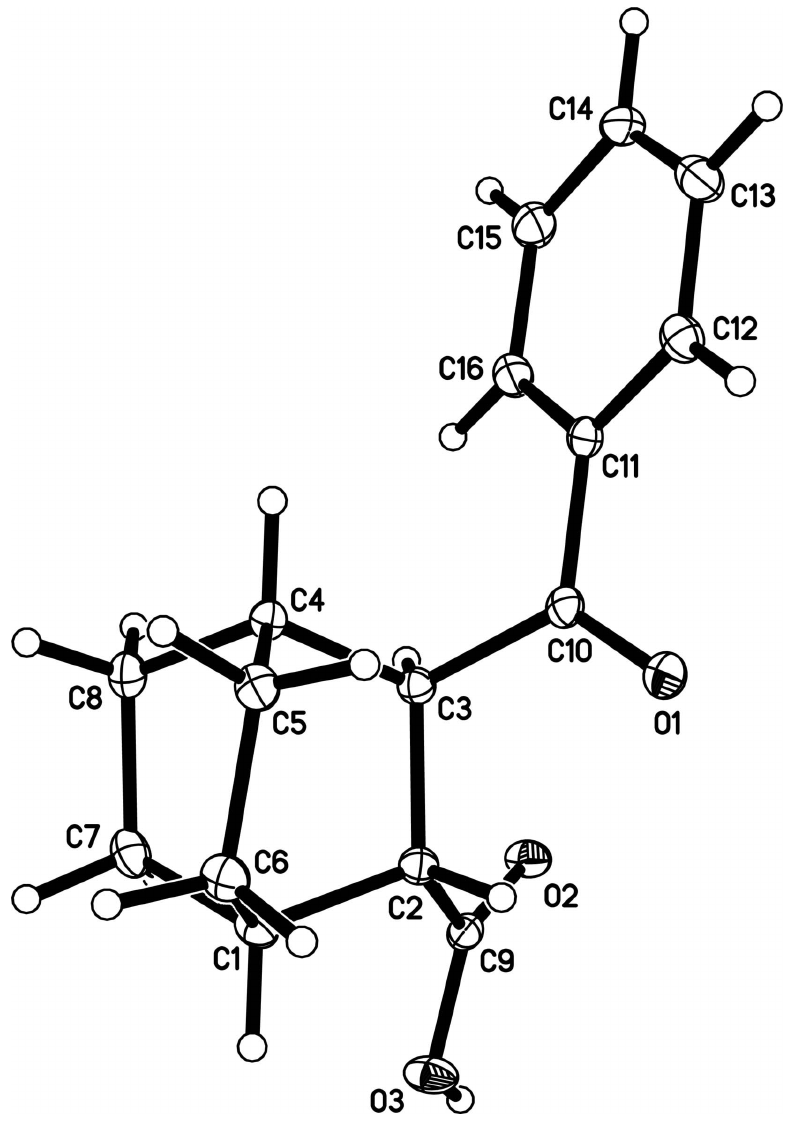
Figure 1 The asymmetric unit with its numbering. Displacement ellipsoids are drawn at the 40% probability